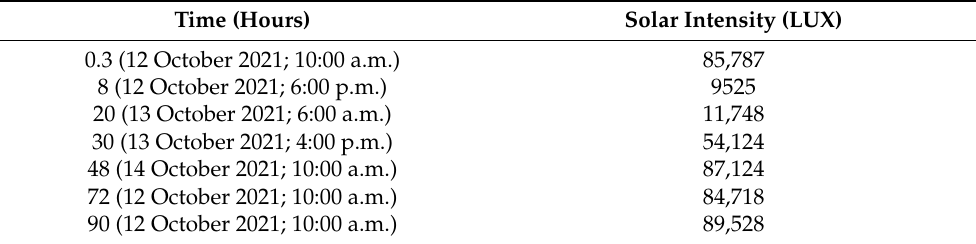
Figure 7. The typical chromatograms of the 30th hour show the following: ( a ) Sandy Loam control; ( b ) Sandy Loam pesticide residues; ( c ) Sandy Clay control; ( d ) Sandy Clay pesticide residue. Table 7. The intensity of solar radiation measure at different time intervals